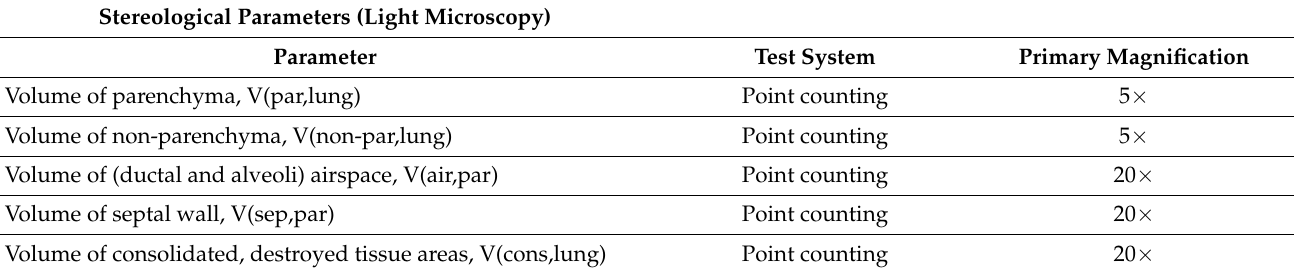
Table 4. Definition of light microscopic stereological parameters.